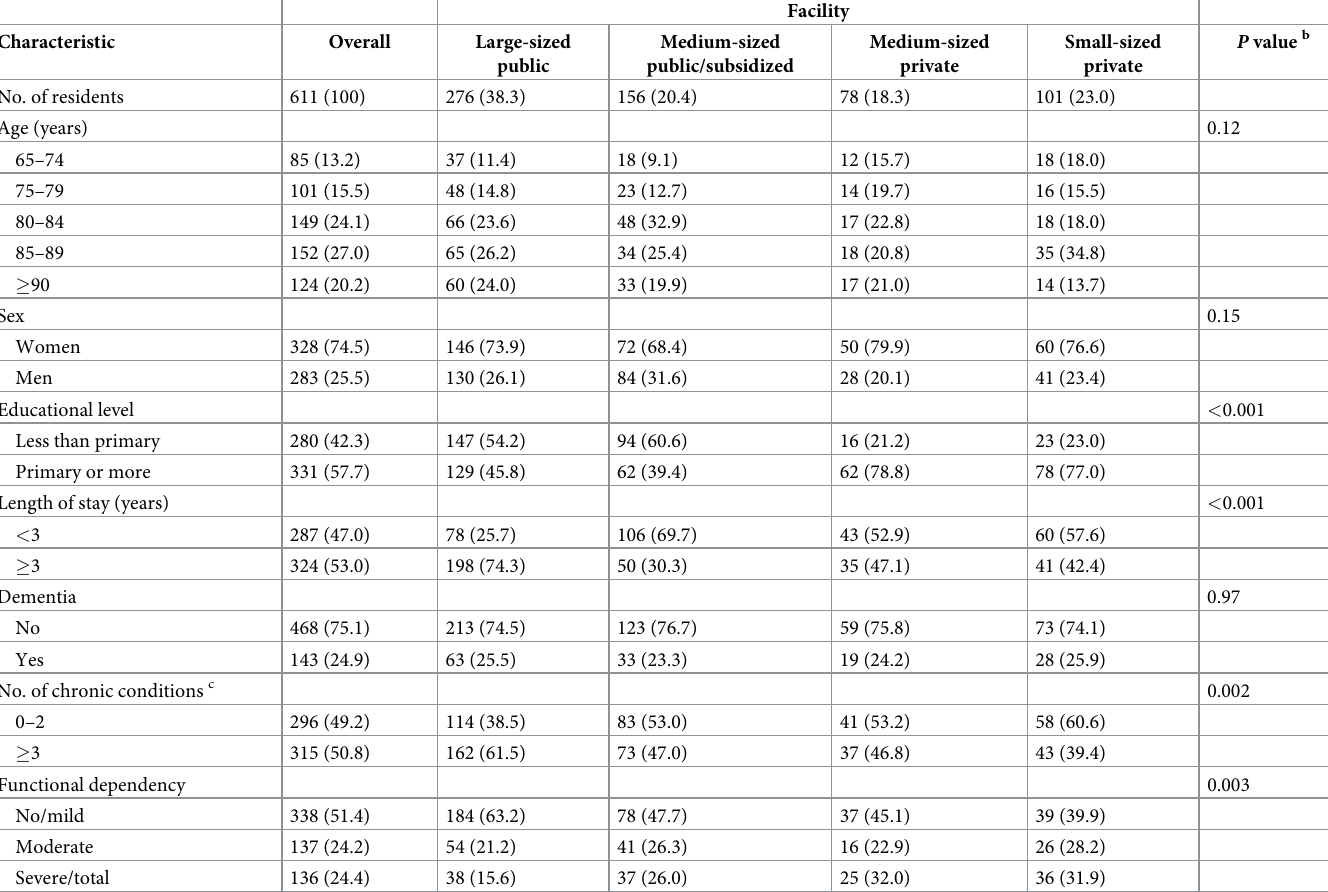
Table 1. Baseline characteristics of institutionalized residents by type of facility in city Madrid, Spain, 1998–1999 a